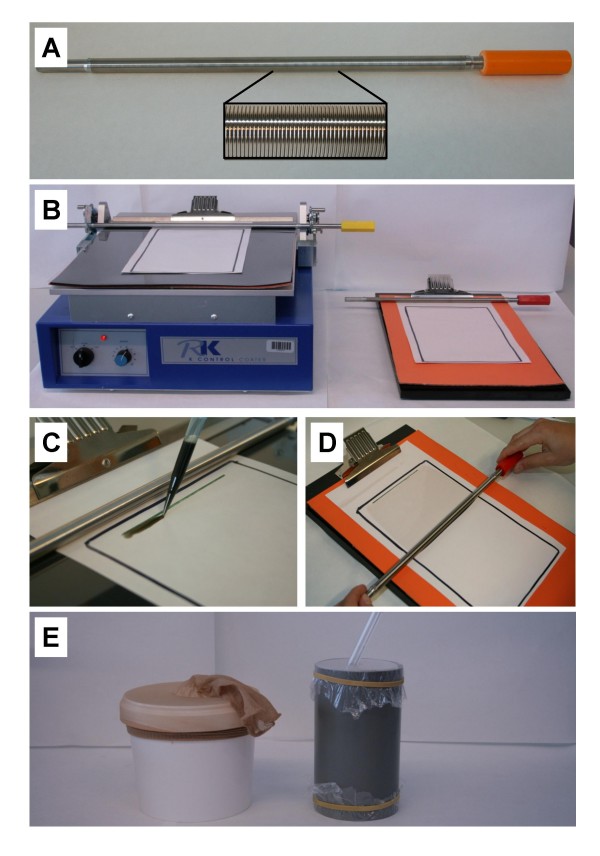
K bar coating of fungal spores. (A) The stainless steel K-bar with wired grooves (inset) that control film thickness. (B) Automated (left) and manual K-Coater (right). (C) Application of fungal spore suspension on the centre top part of the paper substrate with a pipette. (D) Coating a paper substrate with spore suspension using a swift top-to-bottom movement of the bar using light pressure. (E) The mosquito exposure set-up with a coated paper inside a PVC tube (right), sealed with plastic foil. Mosquitoes were transferred into the holding tube with an aspirator and (after exposure) to the holding buckets (left) via free flight.